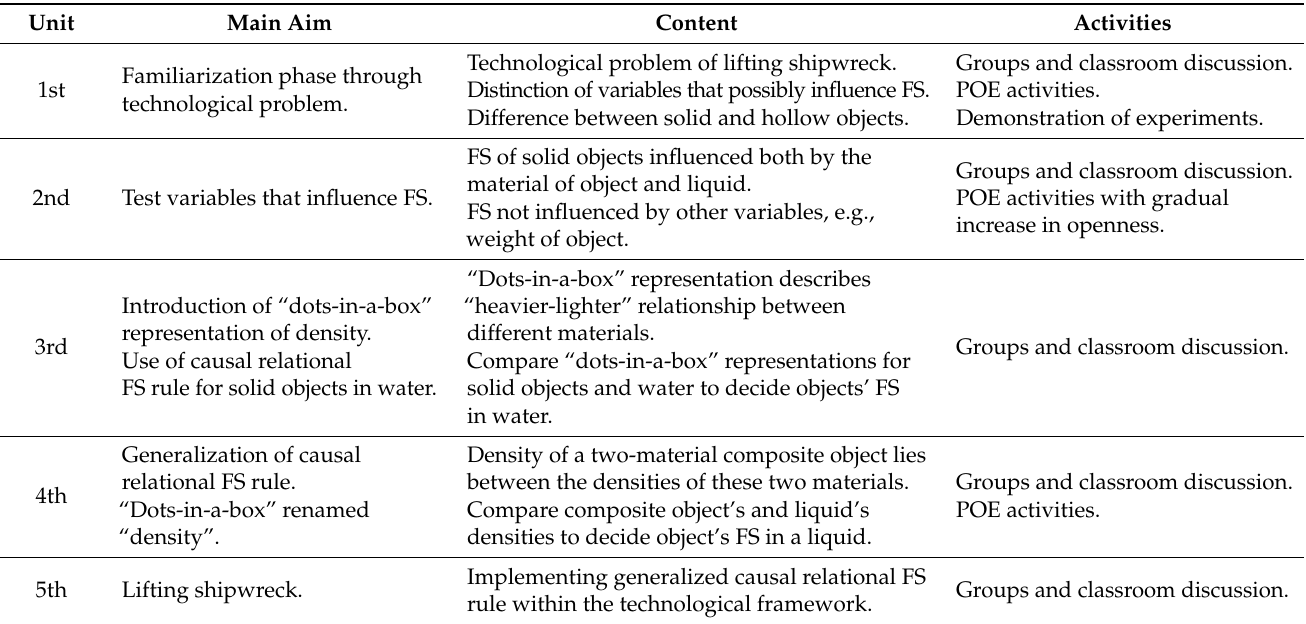
Table 1. Main aim, content and activities concerning FS in the five units of the TLS.